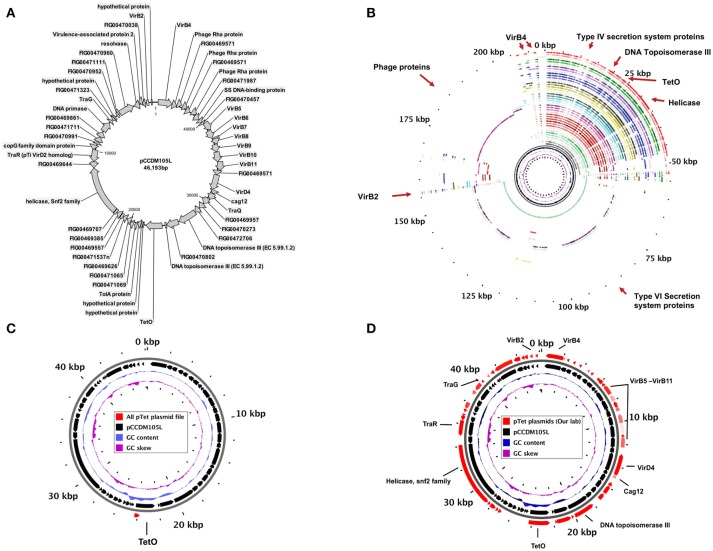
(A) Circular map of pTet (type-1) plasmid (pCCDM105L) showing the presence of various genes, (B) pangenome of pTet plasmids avialable in Genbank (incuding all pTet plasmids from our laboratory), (C) core genome for all pTet plasmids (red arrows in the outer circle indicate the core genome of all plasmid sequences used in the study), and (D) core genome among pTet plasmids isolated and sequenced from our laboratory.